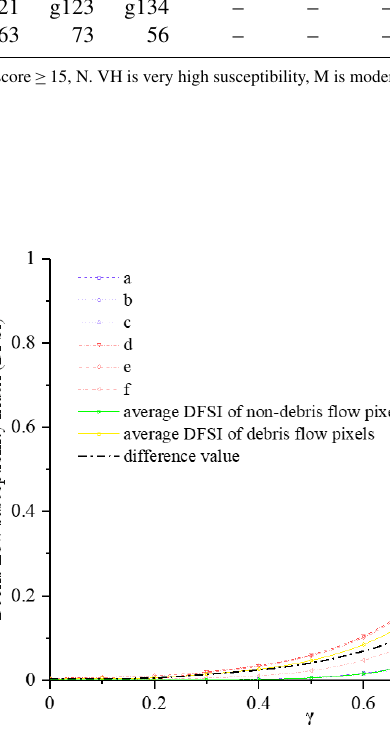
Figure 6. Effect of γ value on debris flow susceptibility index (DFSI). Curves d, e and f correspond to debris flow pixels, and curves a, b and c correspond to non-debris flow area where a de- bris flow is unlikely. According to curve i, the maximum difference between the average DFSI values is observed for γ ≈ 0 .